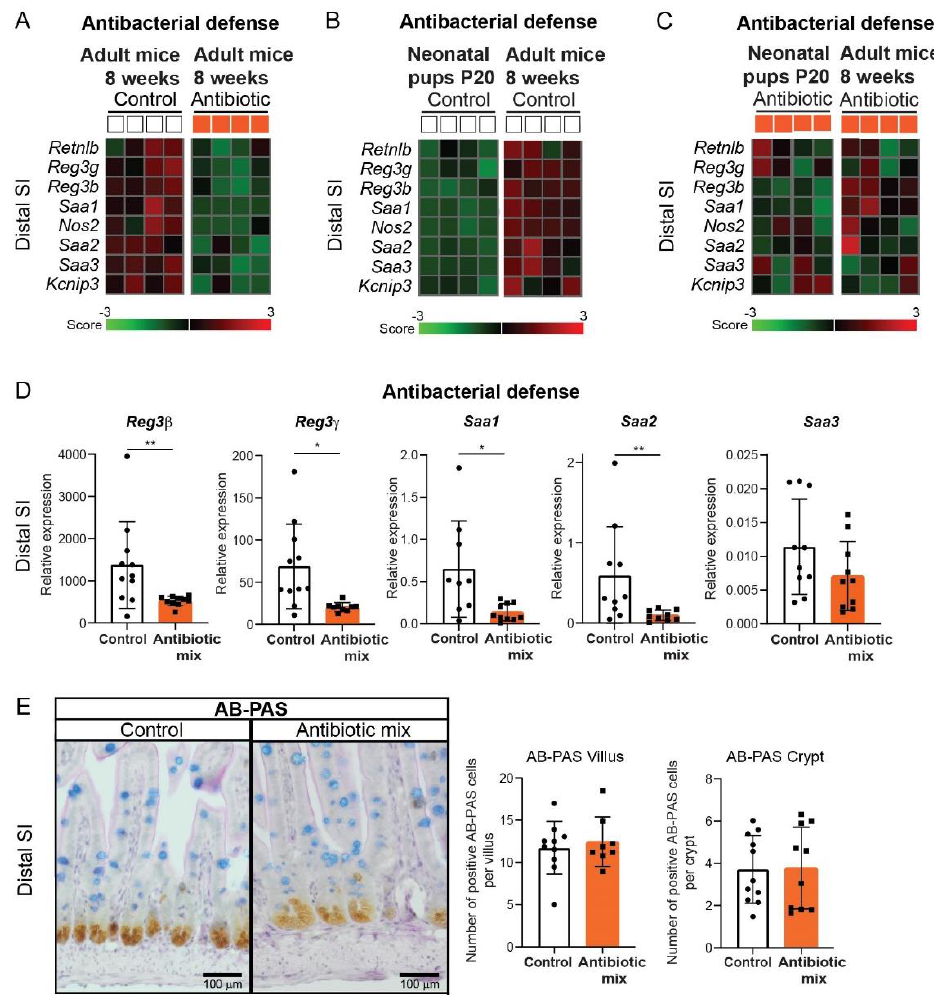
Figure 5. Reduced antibacterial defense in distal small intestine of adult mice treated with early life antibiotics. Differential gene expression analysis of sorted intestinal epithelial cells after antibiotic treatment. ( A – C ) Curated heatmaps of selected genes from top downregulated and top upregulated genes, based on biological interest and grouped according to function “antibacterial defense” in distal epithelial cells of control and AB-treated adult mice ( A ), control neonatal pups and adult mice ( B ), and AB-treated neonatal pups and adult mice ( C ). The colored bar represents the expression level from low (green) to high (red), n = 4 samples per group. ( D ) Whole tissue real-time qPCR analysis of antibacterial defense markers Reg3 β , Reg3 γ , Saa1, Saa2, and Saa3 in distal small intestine. Relative expression to reference genes Rpl4 and Ppib. Reg3 β : n = 11 control mice, n = 10 AB-treated mice. Reg3 γ : n = 11 control mice, n = 10 AB-treated mice. Saa1: n = 9 control mice, n = 10 AB-treated mice. Saa2: n = 10 control mice, n = 9 AB-treated mice. Saa3: n = 10 control mice, n = 10 AB-treated mice. ( E ) Staining and quantification of mucins in villus and crypts of distal small intestine. Villi: n = 10 control mice, n = 8 AB-treated mice; crypts: n = 11 control mice, n = 10 AB-treated mice. (Scale bars, 100 µ m.) Statistical analysis by ANOVA eBayes, p < 0.05 cut-off ( A – C ) or by one-tailed unpaired t -test or Mann–Whitney test (Reg3 β , Saa2), when data were not normally distributed as assessed by D’Agostino and Pearson normality test (Sct). Error bars indicate the mean ± SD. Levels of significance are indicated (* p < 0.05, ** p <